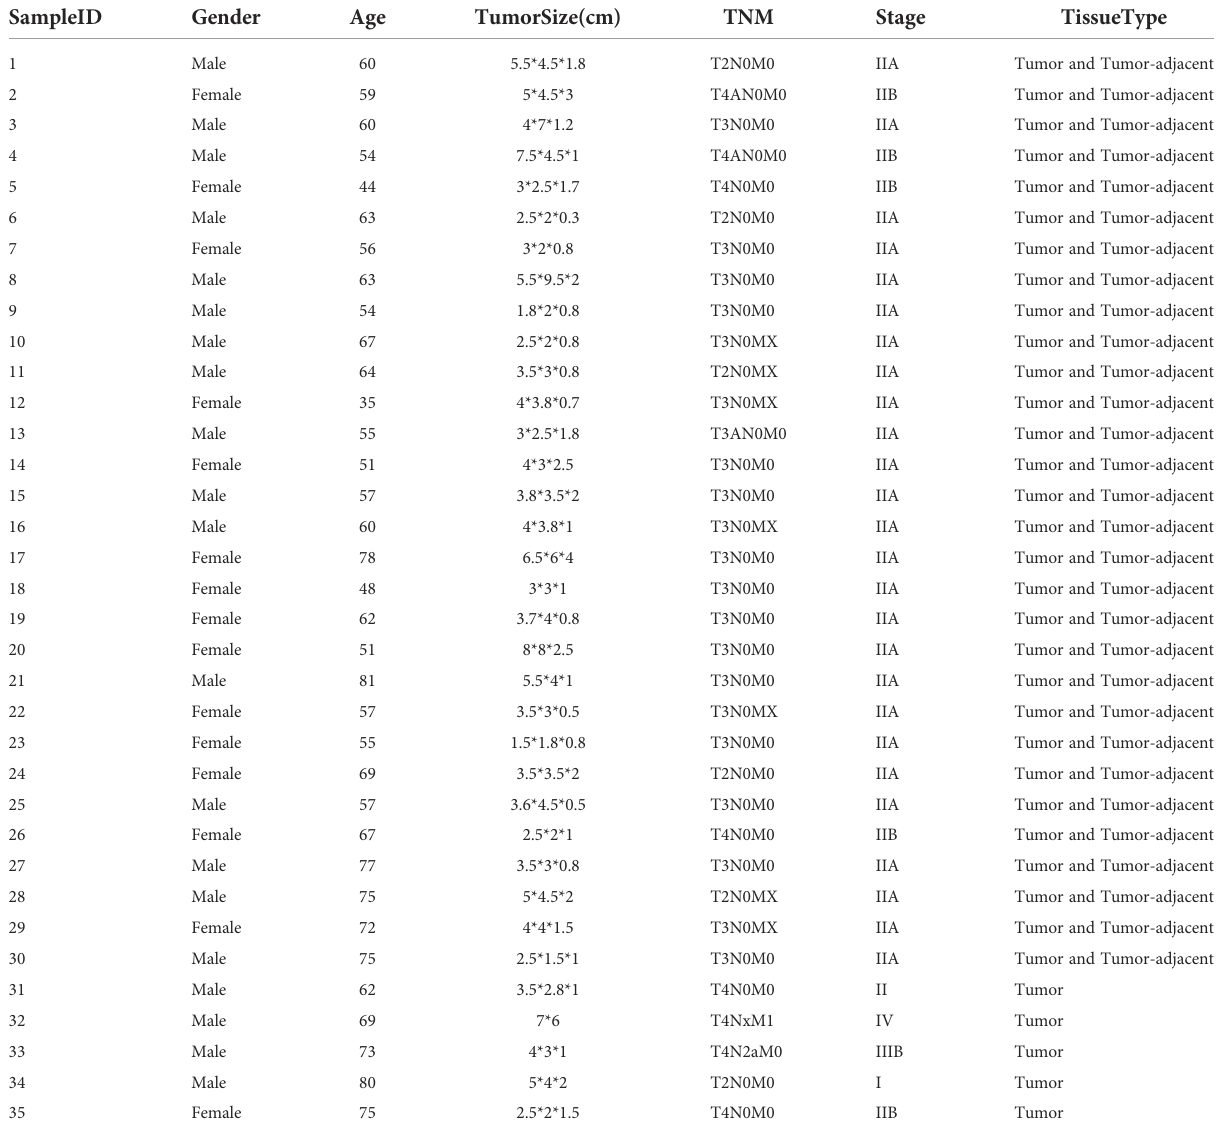
TABLE 6 The characteristics of the CRC tissue